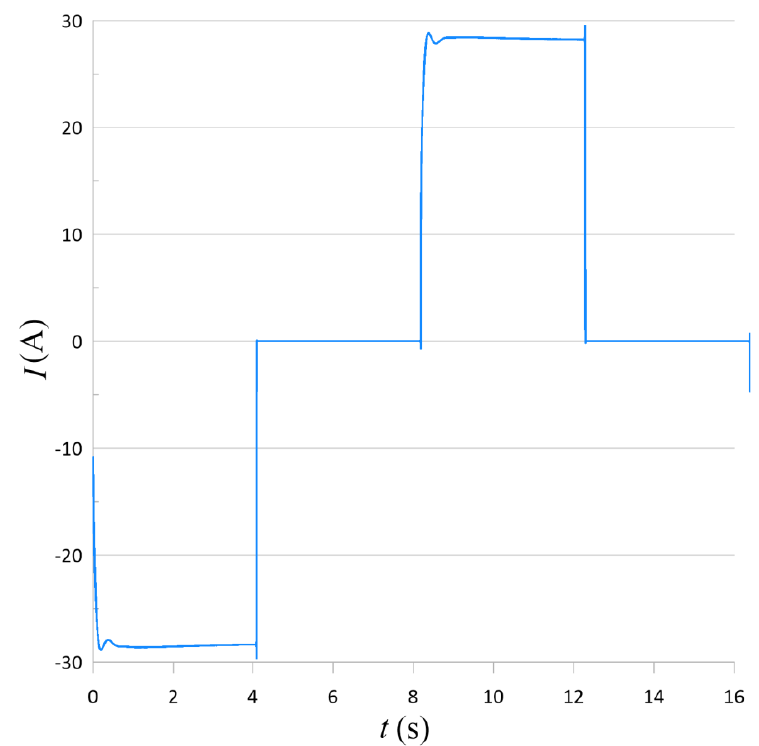
Figure 21. Current waveform of the transmitter.